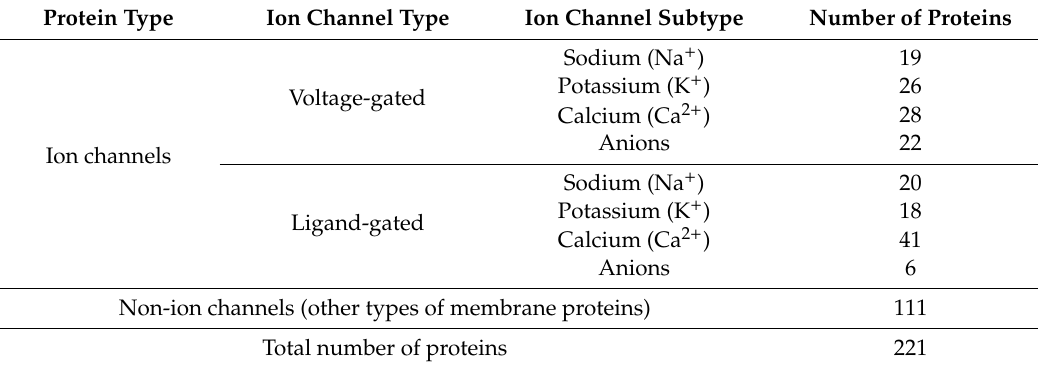
Table 1. Summary of the benchmark multi-label dataset.